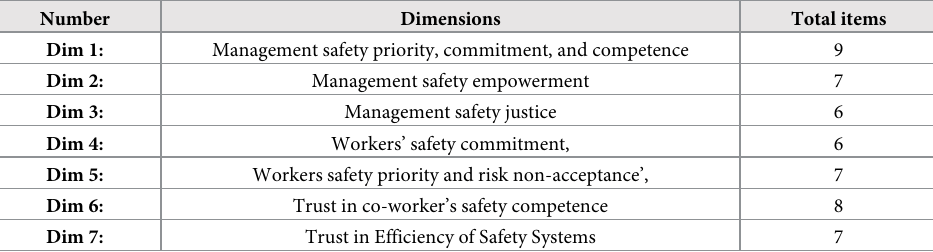
Table 1. NOSACQ-50